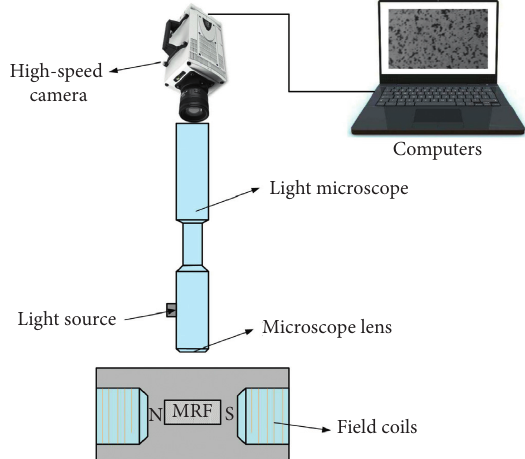
Figure 4: Diagram of MRF microstructure observation device.